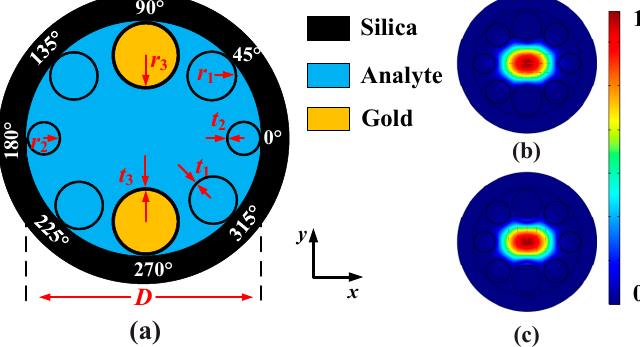
Figure 1. ( a ) The cross-sectional structure of the designed gold wires-filled HC-NCF, where the angle between the adjacent two silica tubes is 45°. ( b , c ) show the mode field distributions of the x -pol and y -pol core modes calculated at wavelength 1.40 μ m.